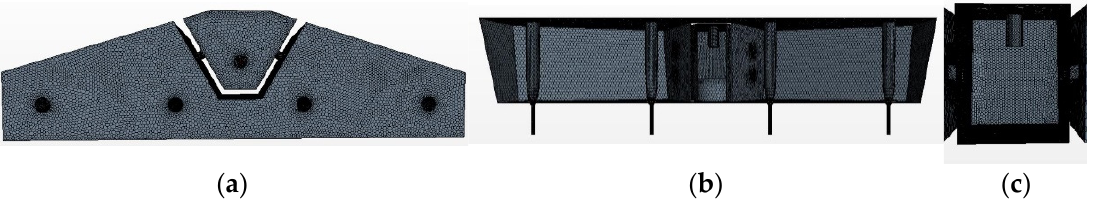
Figure 3. Mesh of four-strand tundishes, ( a ) Front view of u-shaped weir and four-strand tundish; ( b ) top view of u-shaped weir and four-strand tundish; ( c ) pouring chamber of double weir in four-strand